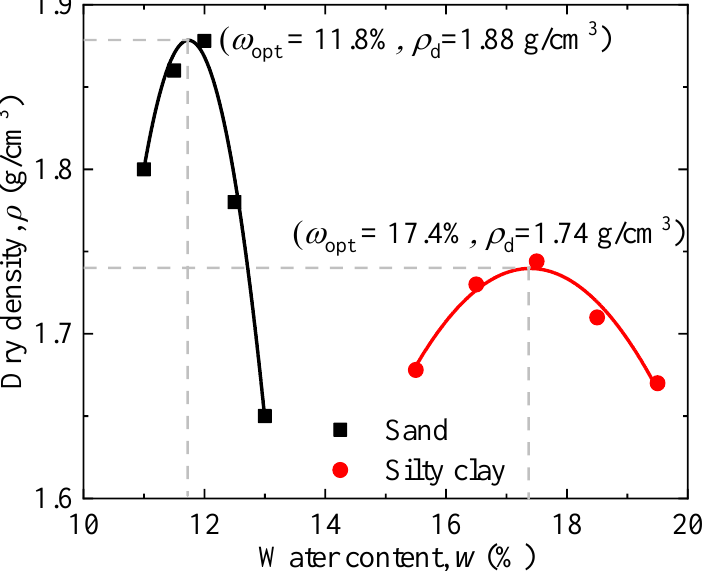
Figure 2. Particle size distribution curves of the remoulded fine-grained materials (silty clay and sand).